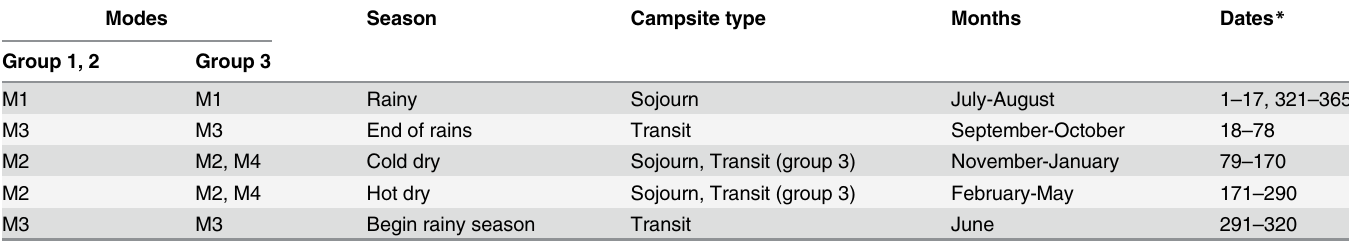
Table 1. Transhumance modes. Modes